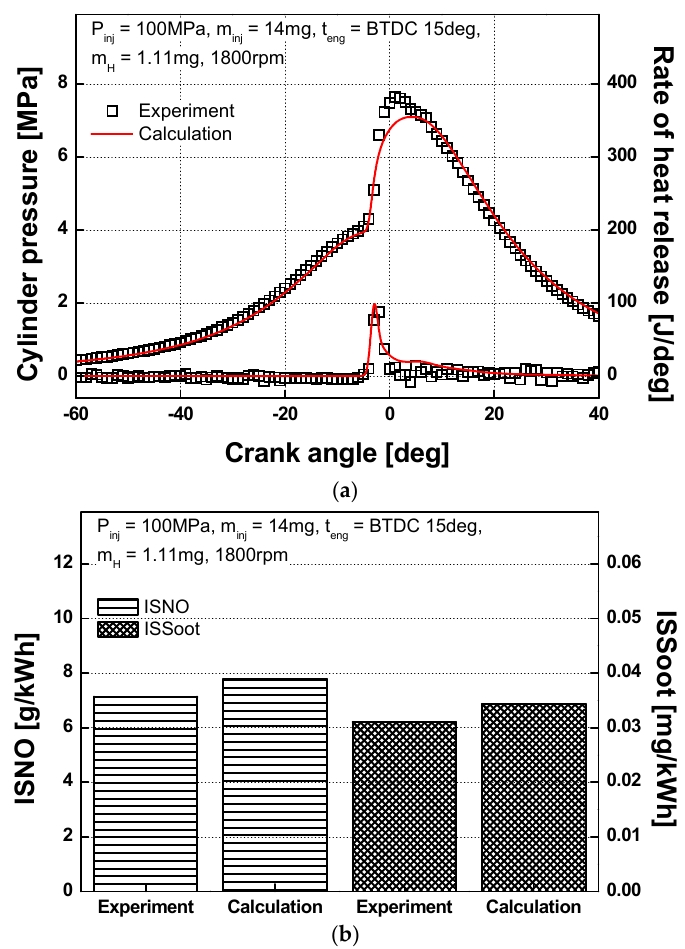
Figure 4. Reliability validation of numerical analysis with experimental results with water vapor injection. ( a ) Cylinder pressure and ROHR; and ( b ) exhaust emissions. P inj = 100 MPa , m inj = 14 mg, t eng = BTDC 15deg, m H = 1.11 mg, 1800 rpm.